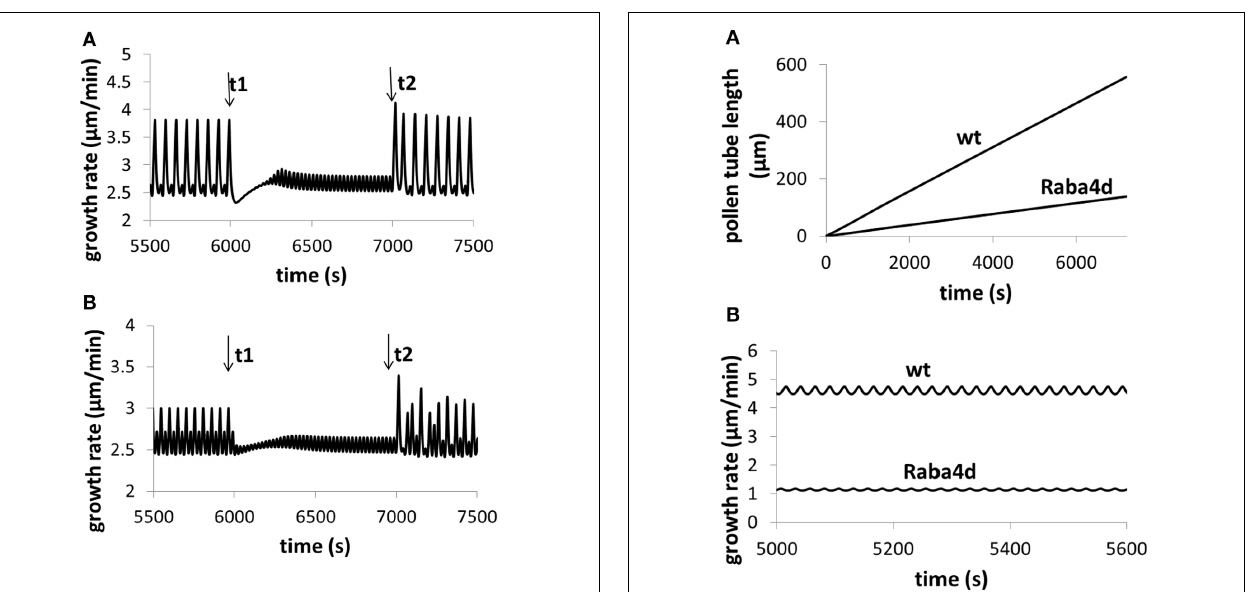
FIGURE 4 | Variation of growth rate for (A) different calcium concentrations in the media, and (B) different p H in the media. Osmolarity in the media is 0.36O sm. (A) At time t1, [Ca 2 + ] in the media increases from 0.13 to 1.3mM (the reference value used in this work is 1mM). The oscillatory amplitude of growth rate decreases and the baseline growth rate increases. At time t2, [Ca 2 + ] returns the original 0.13mM. The oscillatory amplitude of growth rate increases and the baseline growth rate decreases. (B) At time t1, p H in the media decreases to 5.1 from 5.7 (the reference value used in this work is 5.7). The oscillatory amplitude of growth rate decreases and the baseline growth rate slightly increases. At time t2, p H returns the original 5.7. The oscillatory amplitude of growth rate increases and the baseline growth rate slightly decreases. These results are qualitatively in agreement with experimental observations (Messerli and Robinson, 2003), although the range of varying p H in experiments (Messerli and Robinson, 2003) is much wider. Modeling results show that, when [Ca 2 + ] in the media increases from 0.13 to 1.3mM, although oscillatory amplitudes of growth rate change, the average growth rates for the two media conditions are approximately the same. The reason is as follows. The 10-fold increase (from 0.13 to 1.3mM) of [Ca 2 + ] in the media only leads to a change of 0.04 and 0.4% in the osmolarity in the media. Thus, the contribution of this 10-fold of [Ca 2 + ] increase to the osmolarity in the media is insignificant.